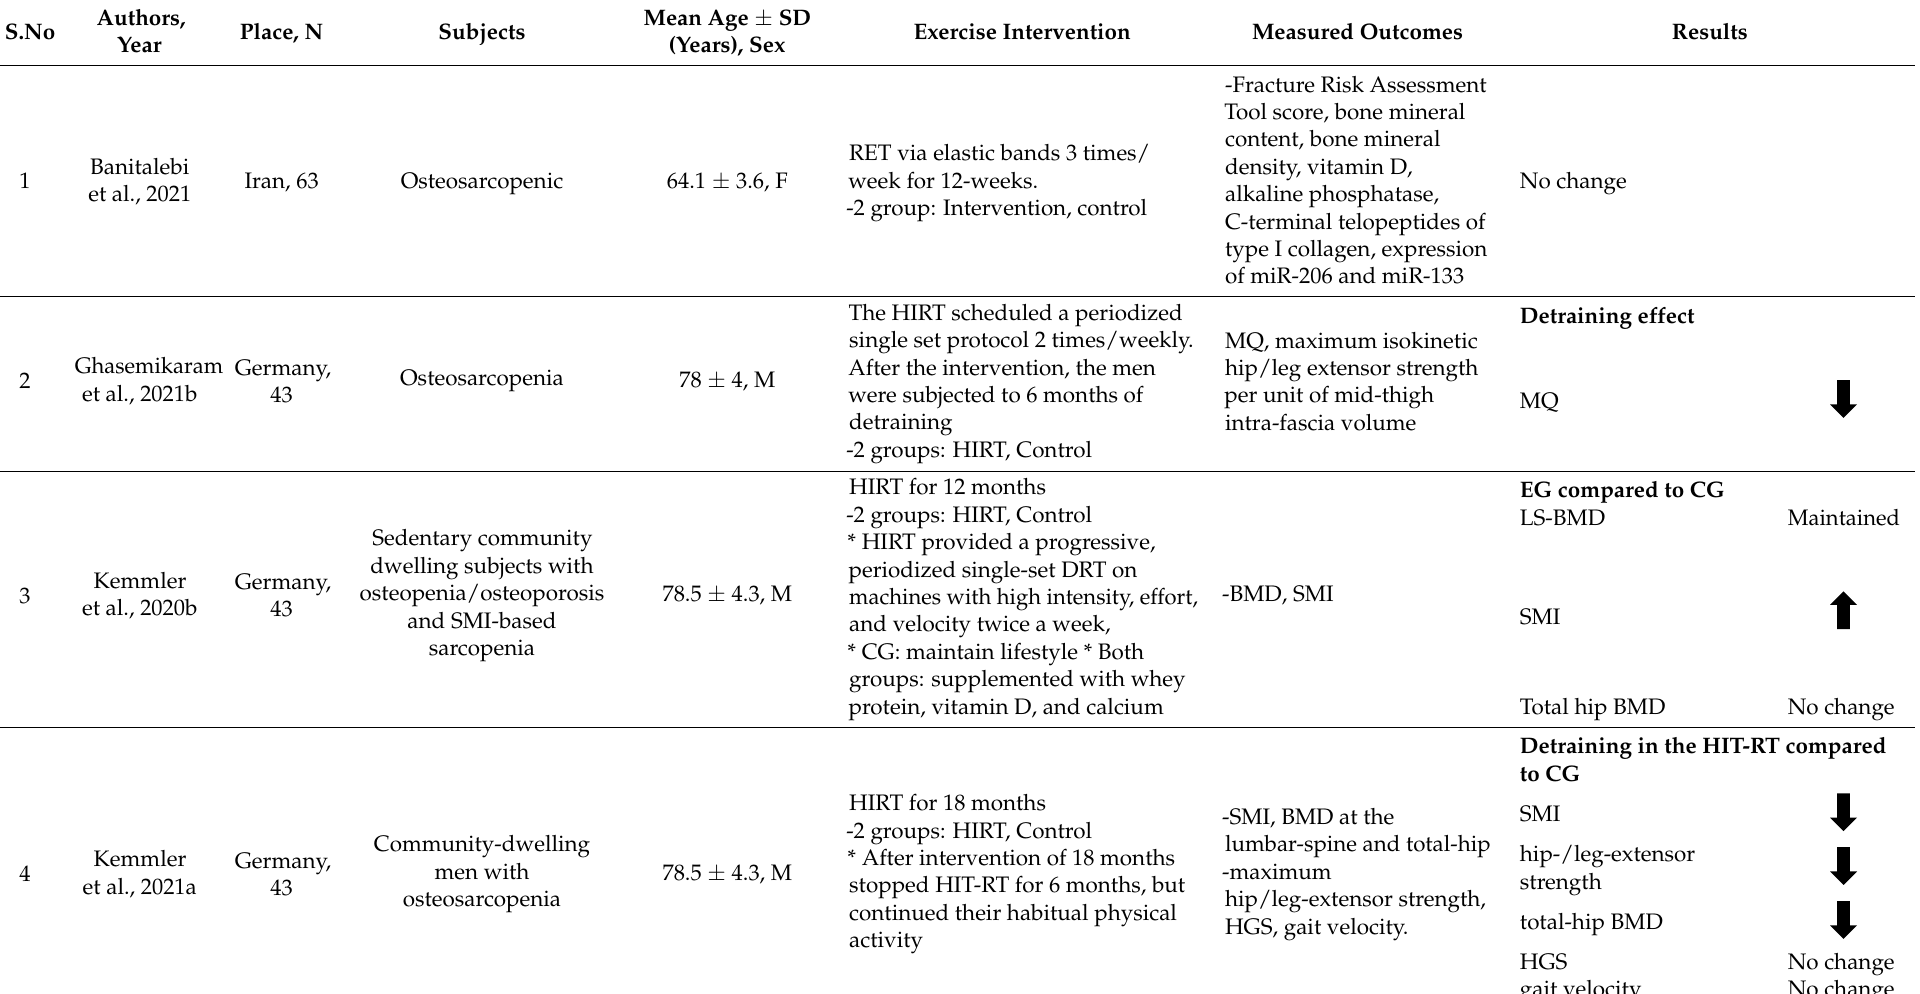
Table 2. Effect of exercise on subjects with osteosarcopenia.